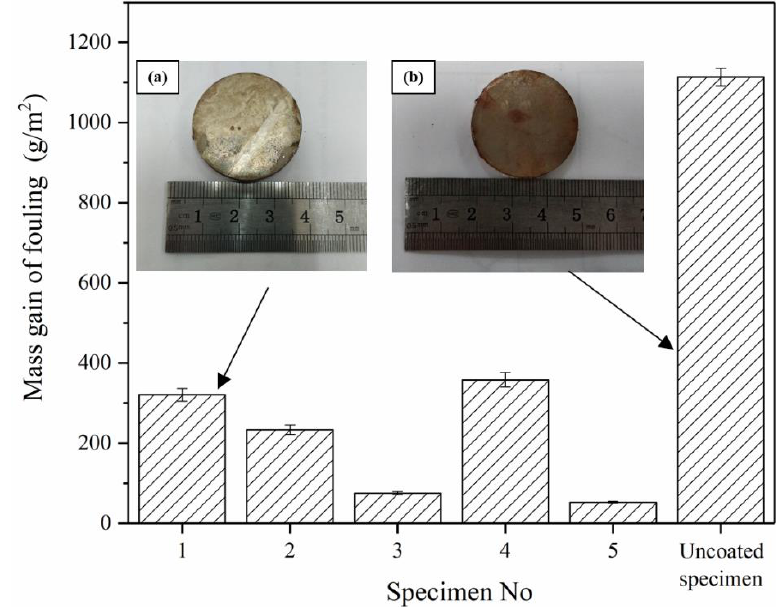
Figure 4. Mass change of coated specimens after 72 h fouling ( a ) macro appearance of specimen with Ni-W-P coating after flow fouling; ( b ) macro appearance of bare specimen after flow